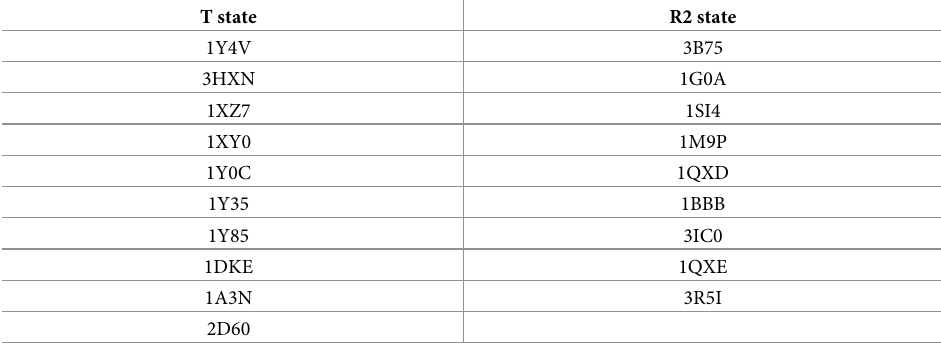
Table 1. DSS based nearest neighbors of hemoglobin T- and R2- state